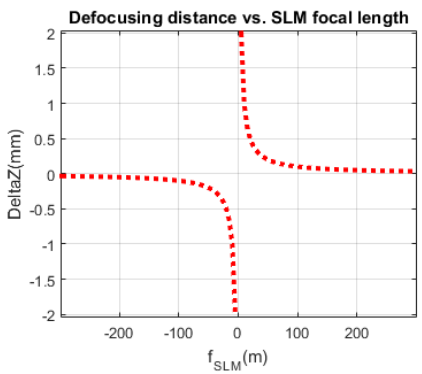
Figure 3. The hyperbolic relation between the focal length 𝑓 𝑆𝐿𝑀 of the quadratic phase pattern displayed on the SLM and the defocusing distance, 𝛥𝑧 .